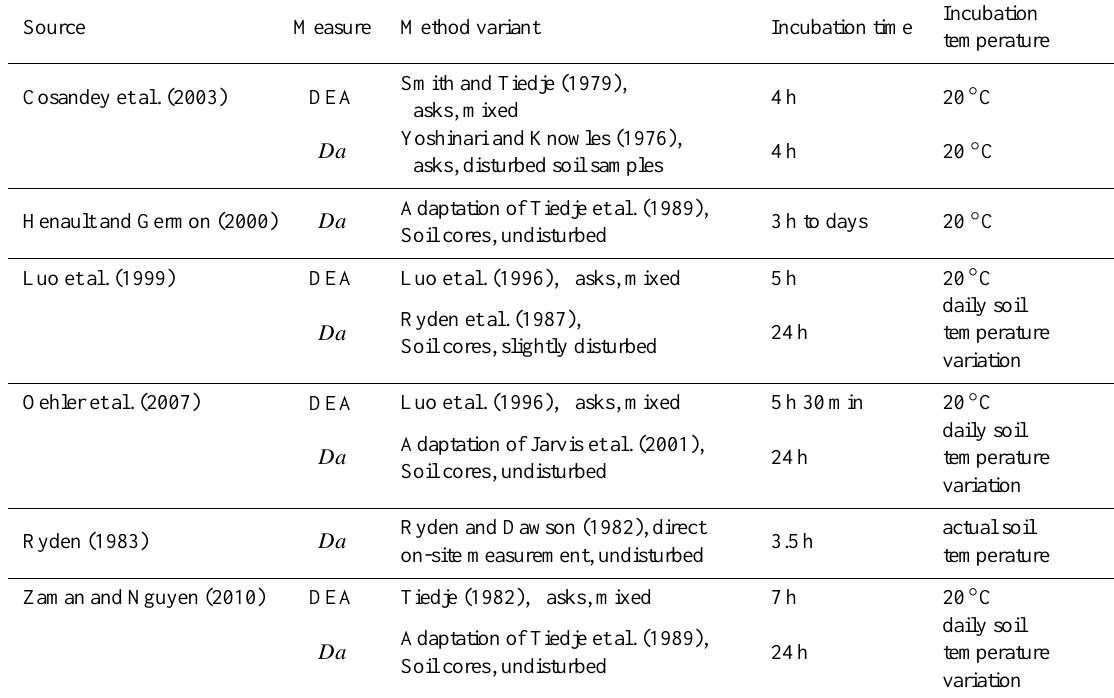
Table 1. The different measurement methods of Da and DEA in the database.